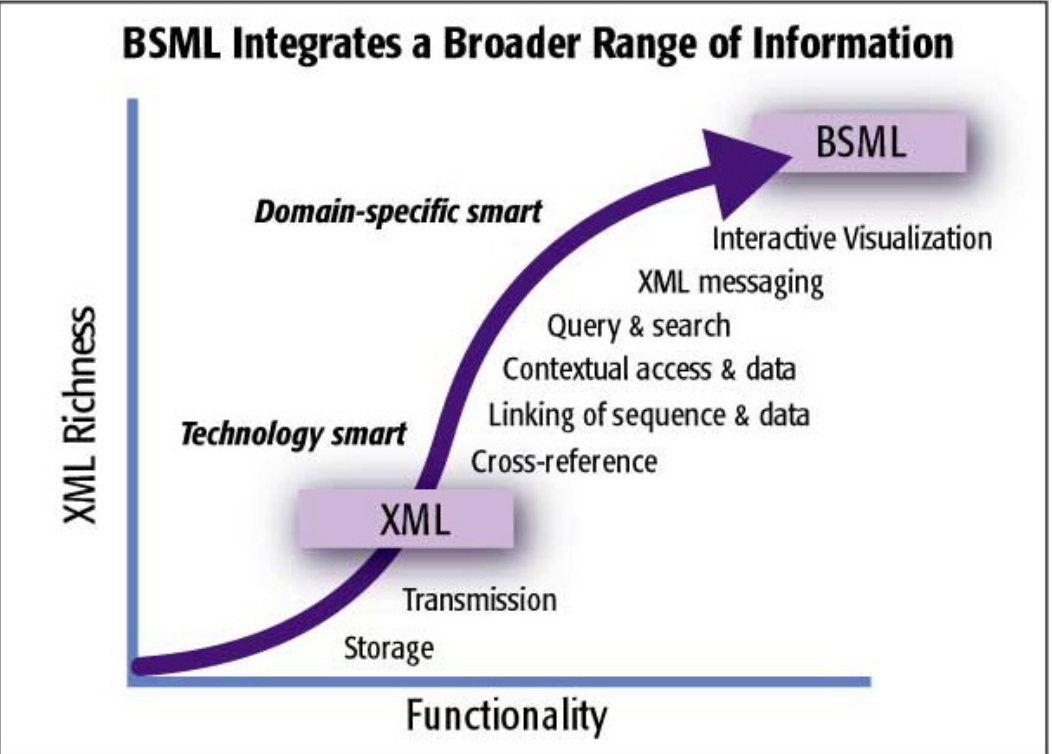
Fig. 2: BSML uses the advantages of XML and adds domain specific functionality and representation of sequence